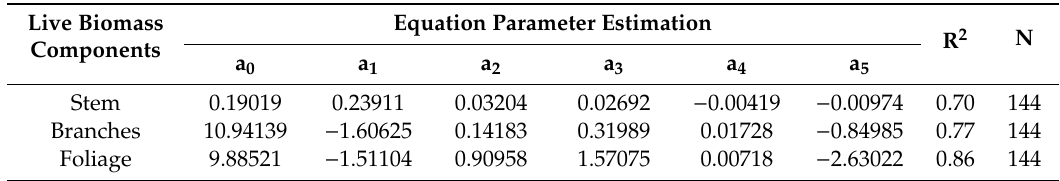
Table 2. Parameters of the forest live biomass of pine